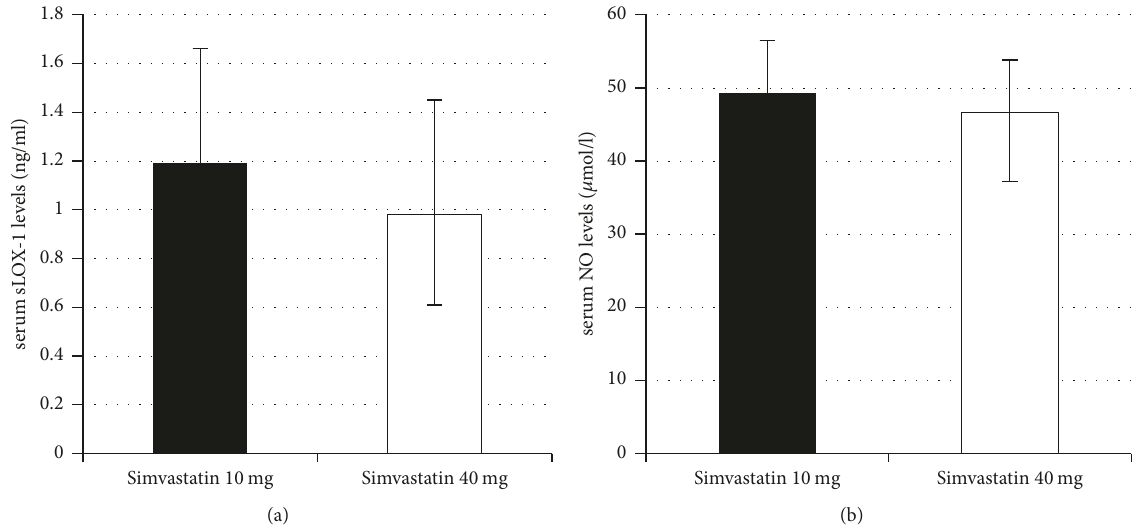
Figure 1: Serum sLOX-1 (a) and NO (b) levels of patients with acute ischemic stroke that compare simvastatin 10 mg/day and 40mg/day at Day 90 after simvastatin treatment. ∗ 𝑃 < 0.05